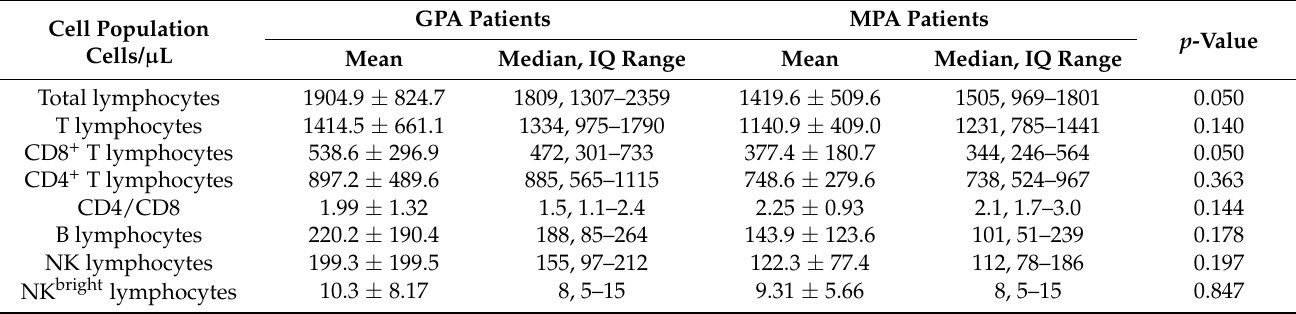
Table 3. General lymphocytes populations in the GPA and MPA